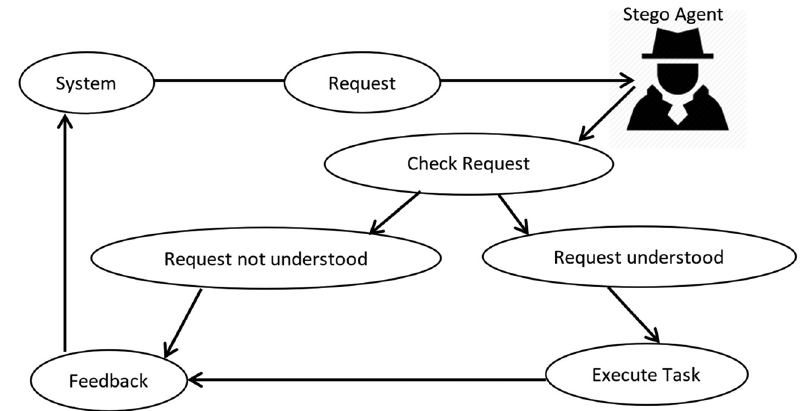
Figure 9: Agent - based image steganography